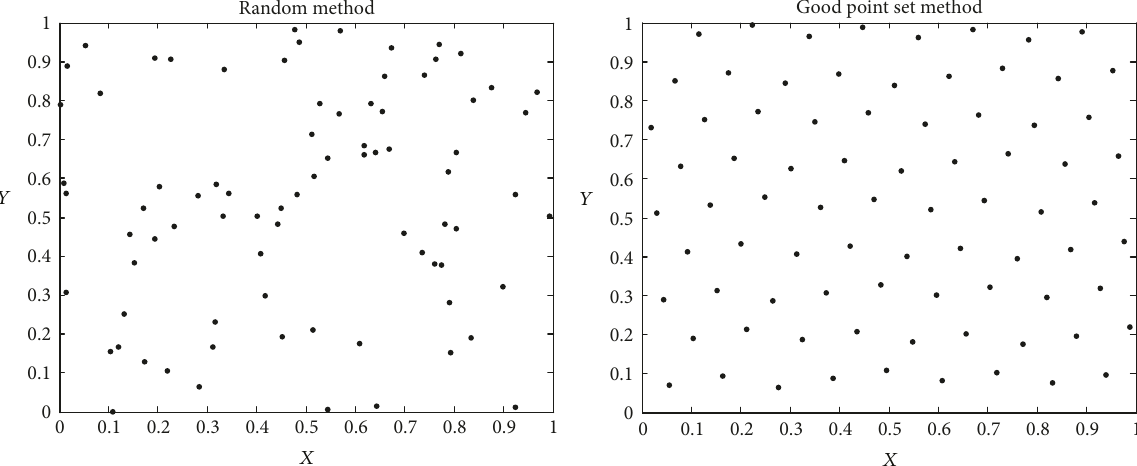
Figure 1: 80 points in the unit squares generated through random and good-point-set